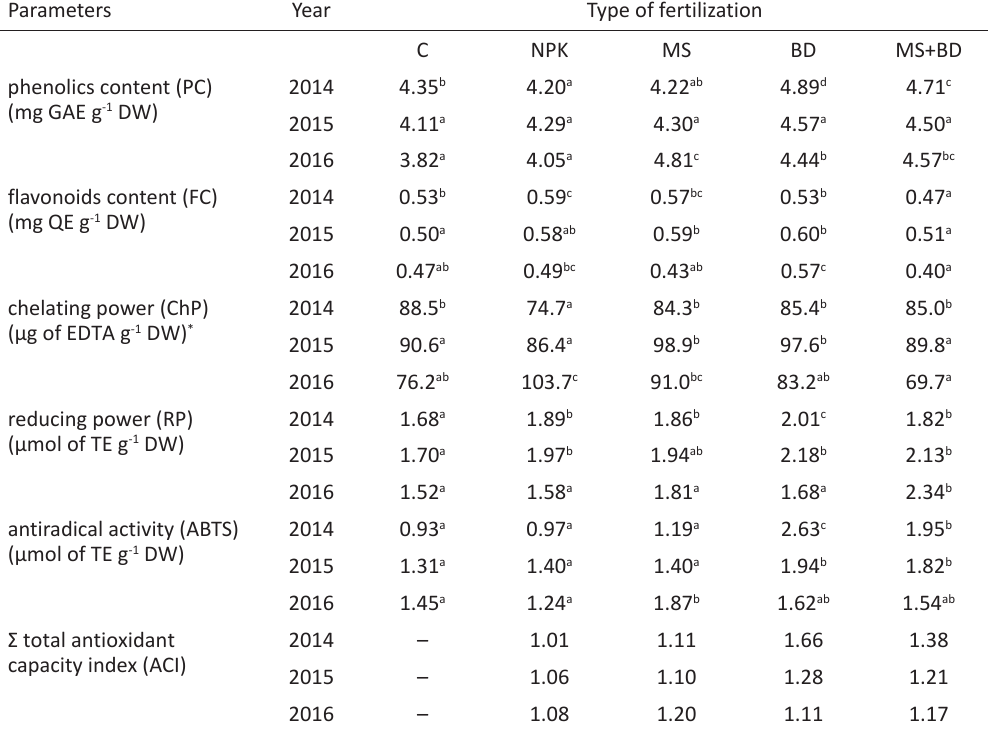
Table 4. Effect of biogas digestate (BD) and mining waste (MS) on the phenolics content and on the antioxidant capacity of winter wheat grain (mean, n = 3) Parameters